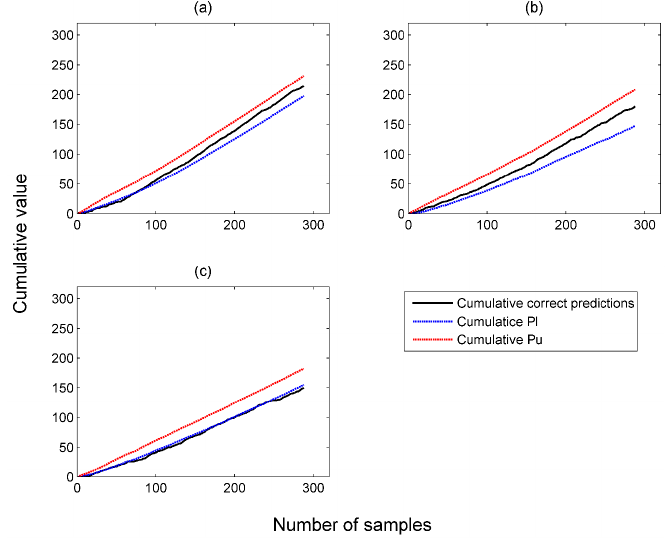
Figure 3. Validity of probabilistic predictions by ( a ) VM-SVM (Venn machine based on SVM); ( b ) VM-SR (Venn machine based on Softmax Regression); ( c ) VM-NB (Venn machine based on Naïve Bayes) in online mode.